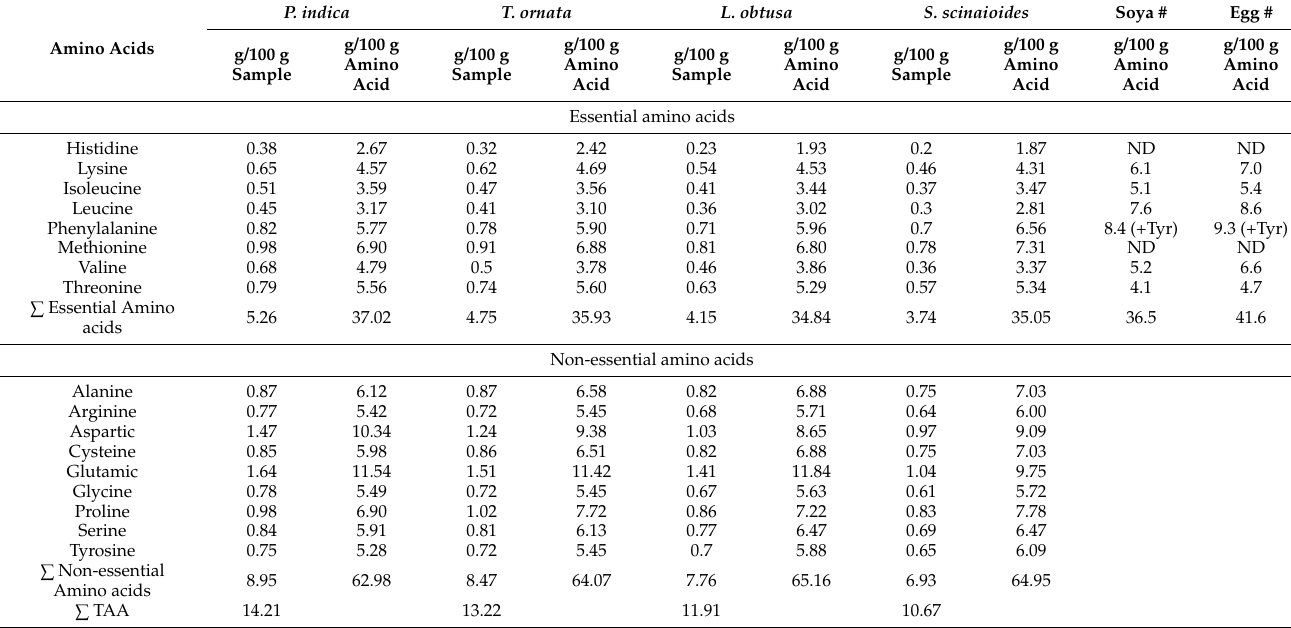
Table 2. Amino acid compositions of the studied Phaeophyceae and Rhodophyceae species (g/100 g sample) and profiles (g/100 g amino